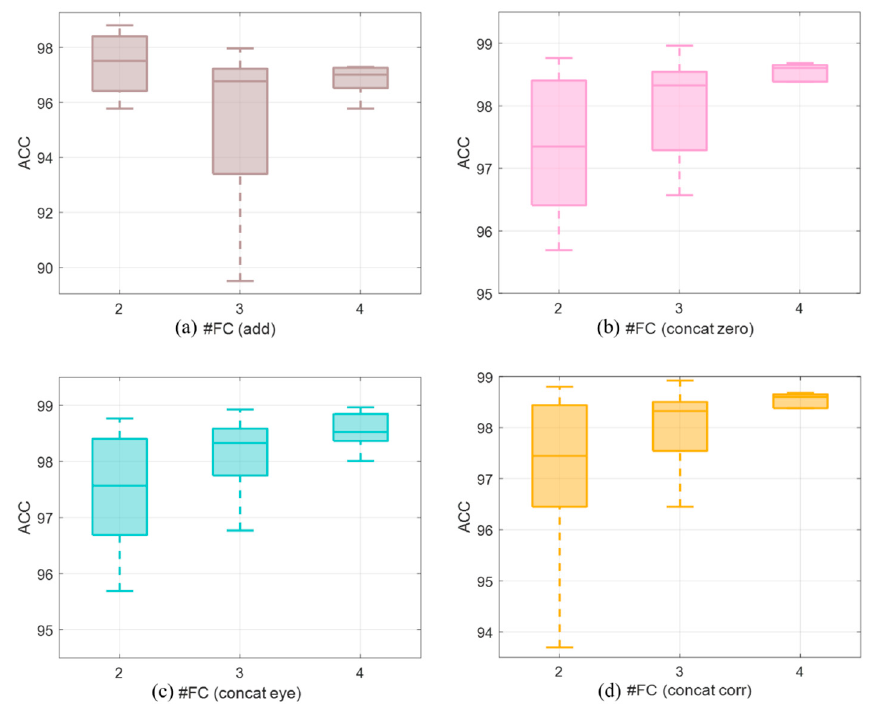
Figure 4. Comparison between using different quantities of FCs with the four fusion methods (( a ): add, ( b ): concat_zero, ( c ): concat_eye, and ( d ): concat_corr). In the add-fusion, when the number of FCs increases, the accuracy does not improve; the highest accuracy was achieved by two-FC combination (subfigure a ). In all three concat-fusions, the accuracy increases with the number of FCs (subfigures b – d ).